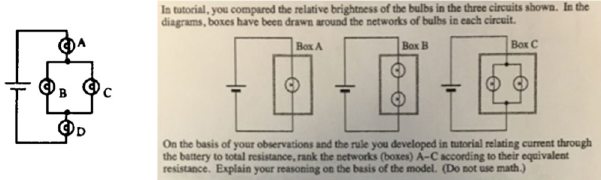
FIG. 3. Left: a circuit diagram used as an evaluation of the conceptual circuit model developed by Shaffer and McDermott [31]. Right: a homework question from the Tutorials in Intro- ductory Physics . Students are asked to rank the resistances of the boxed circuit elements and are explicitly told to not use math in their explanations.